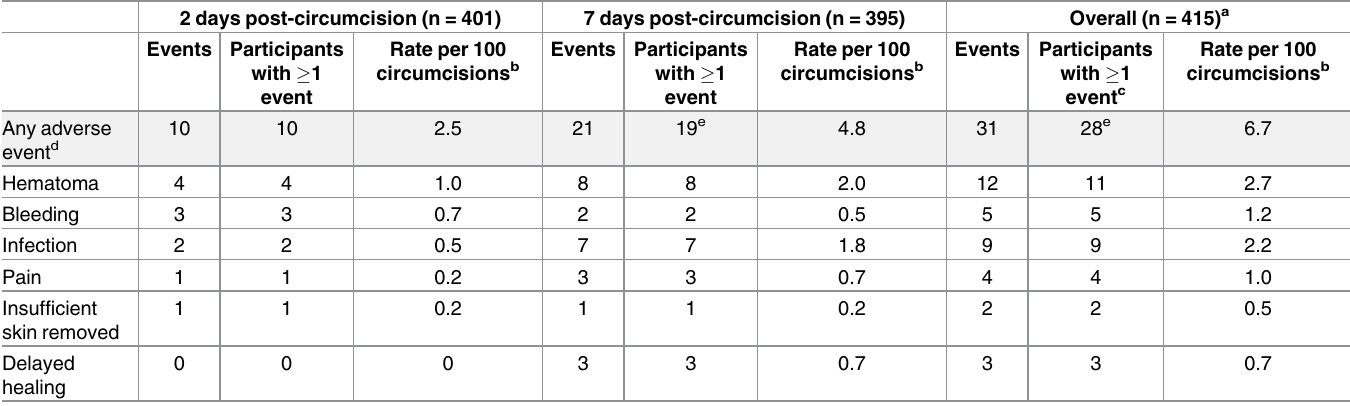
Table 1. Moderate/severe adverseevents observed overall and 2 and 7 days post-circumcision among N = 427 HIV-uninfected, sexually-active adult men surgically circumcised within the National Safe Male Circumcision program in Gaborone, Botswana. 2 days post-circumcision (n =